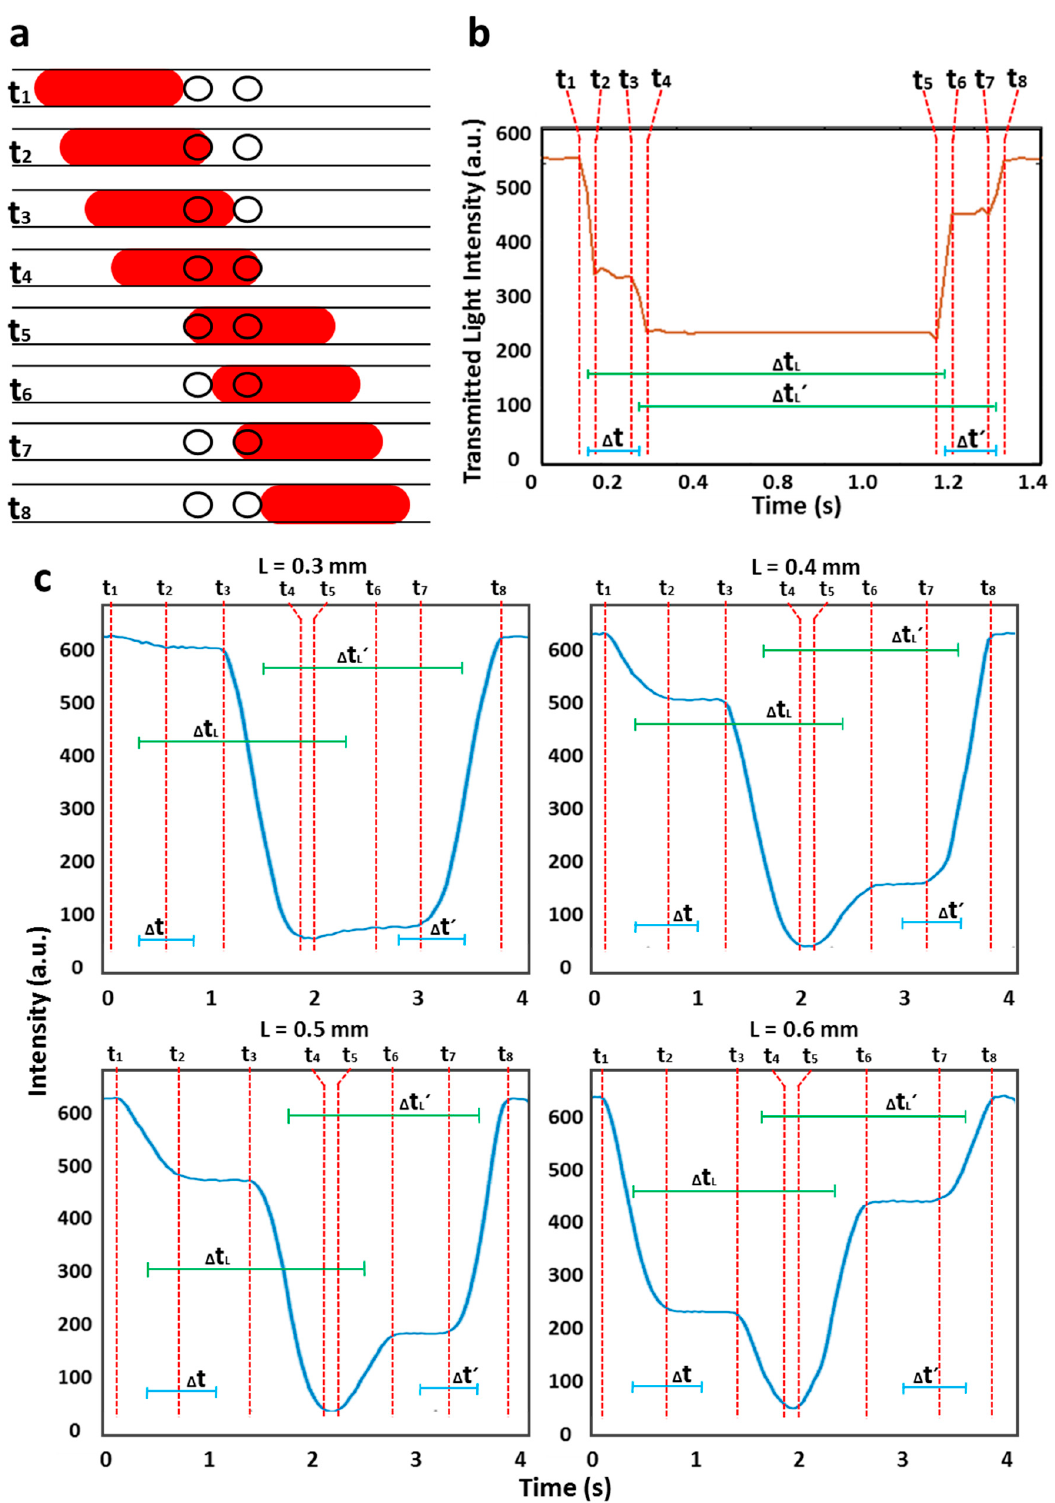
Figure 2. Working principle of the optical flow cell: ( a ) Schematic of the device; ( b ) Plot of transmitted light intensity over time as droplet travels through the holes. The times t 1 → t 8 relate to the moment when droplet enters and exits the holes; ( c ) The graphs showing a drop in intensity levels during the passage of droplets (droplet velocity and length were 1.65 mm/s and 0.94 mm, respectively) from light paths of different distances ( L = 0.3, 0.4, 0.5, and 0.6 mm).